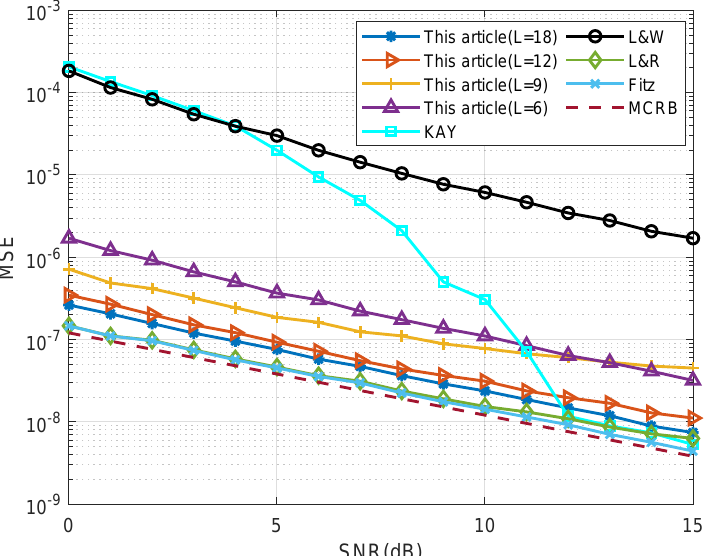
Figure 2. Accuracy of different frequency offset estimation algorithms. MCRB, Modified Cramer–Rao